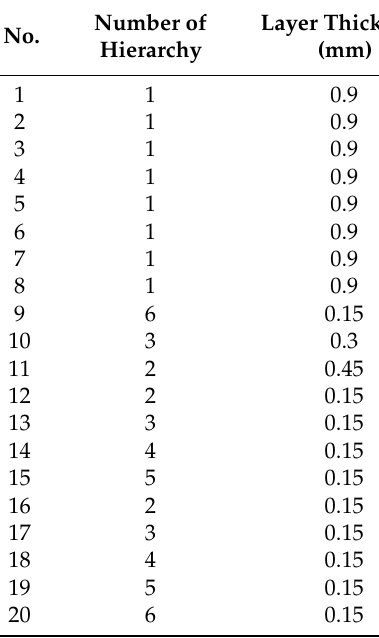
Table 2. Laser power and experimental